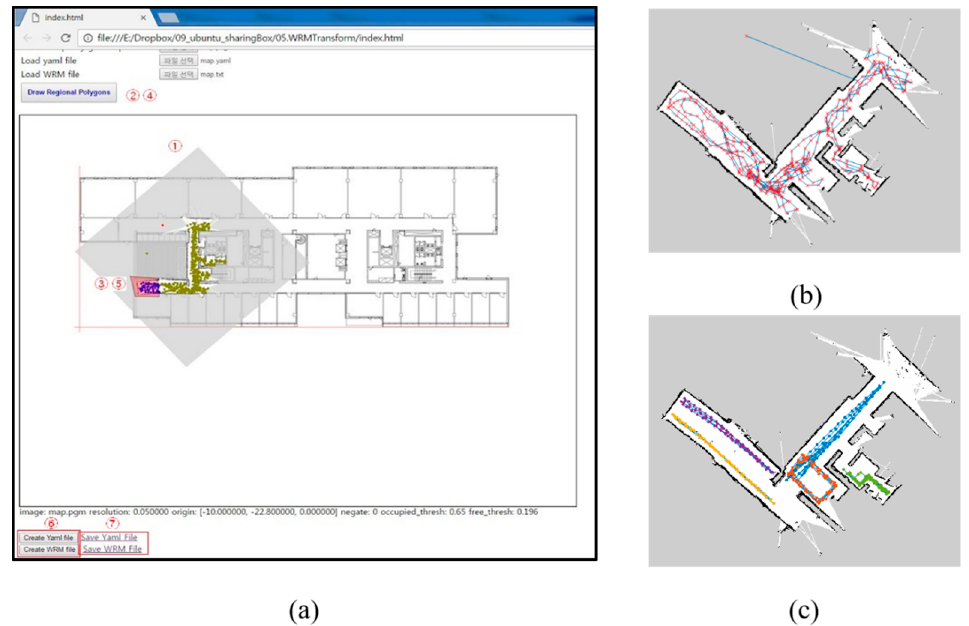
Figure 8. Test space in the Korea Advanced Institute of Science and Technology (KAIST) N1 building: ( a ) visualized test space in the testing tool, ( b ) training data collection path, and ( c ) test data collection path.